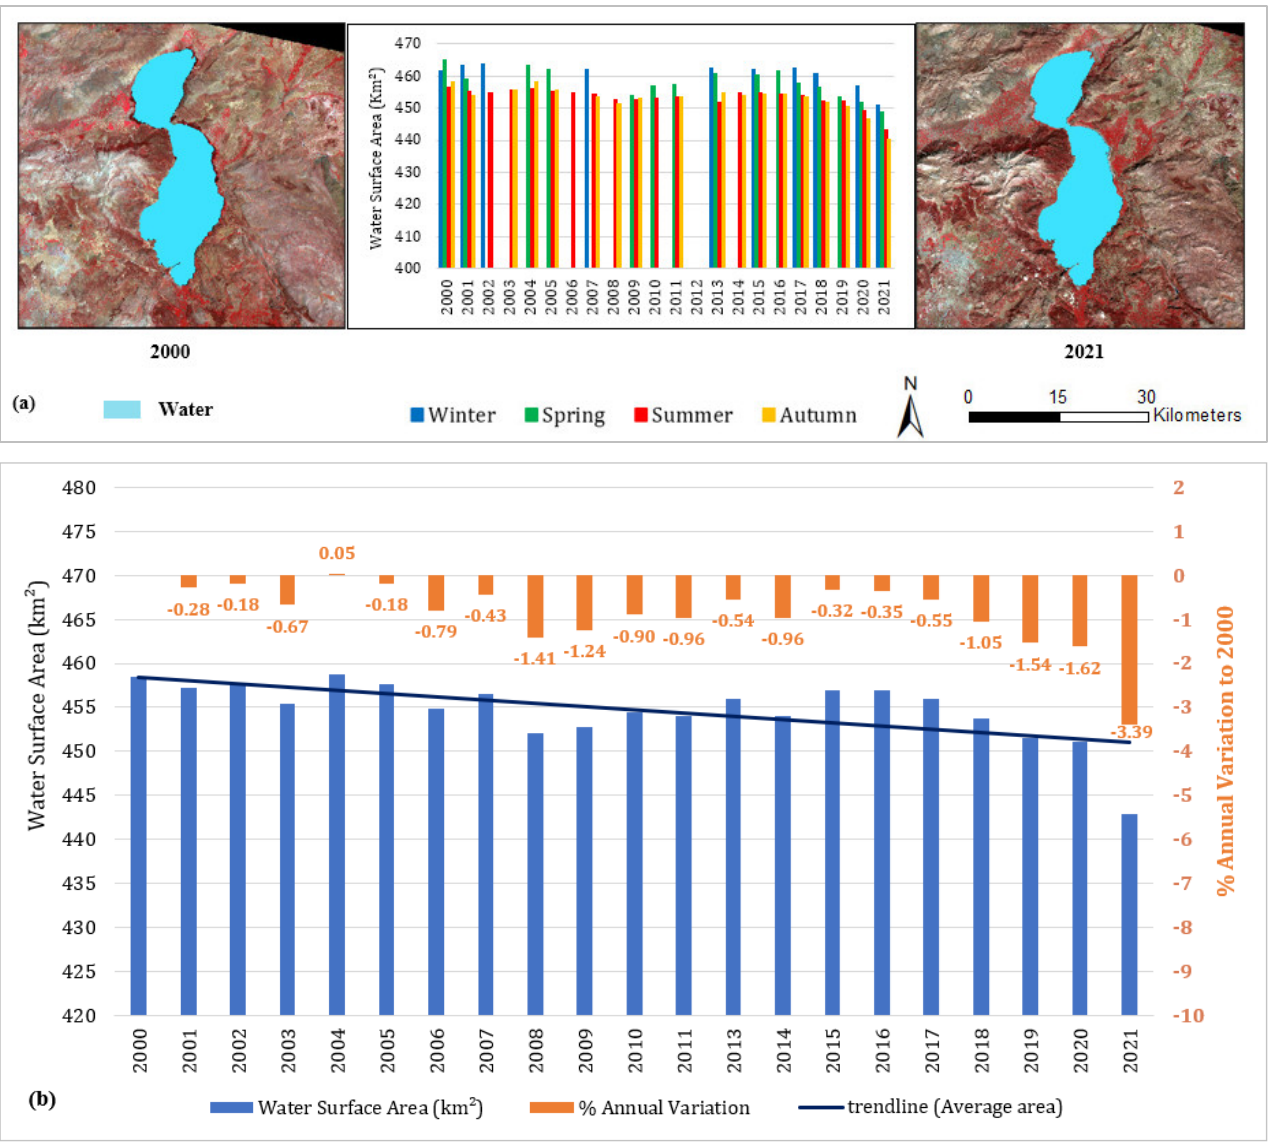
Figure 8. Egirdir Lake’s: ( a ) seasonal water surface area changes with RS images for 2000 and 2021; ( b ) long-term annual water surface area variation.